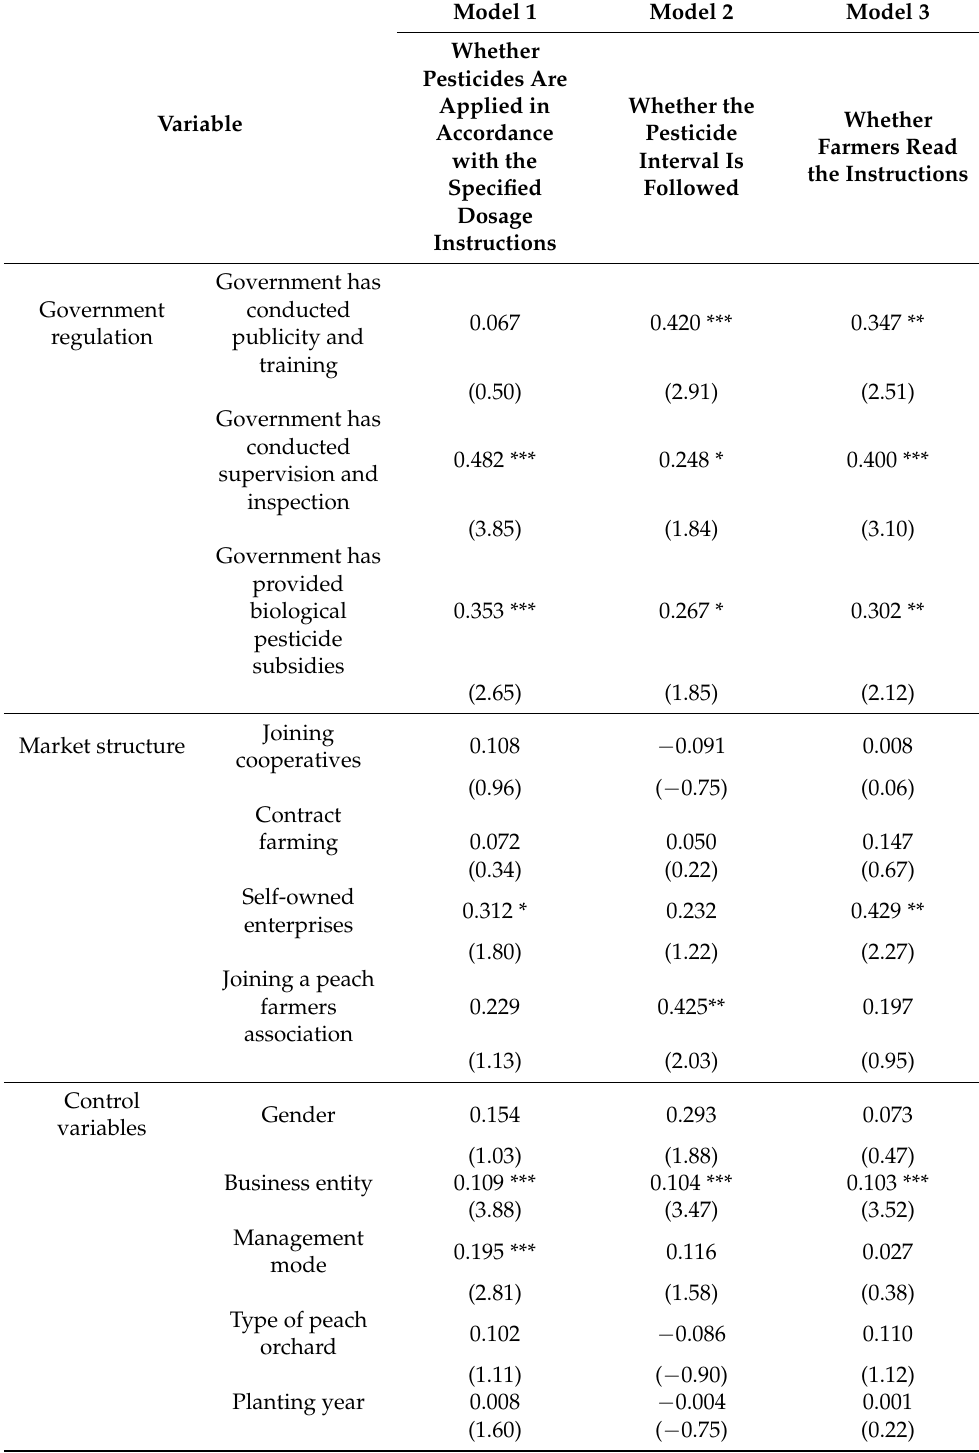
Table 3. Regression results of the benchmark